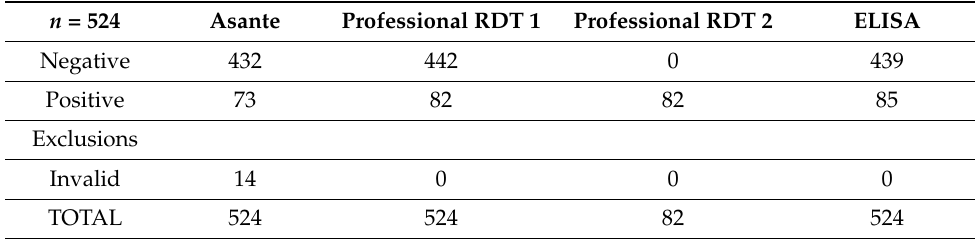
Table 3. Performance evaluation.